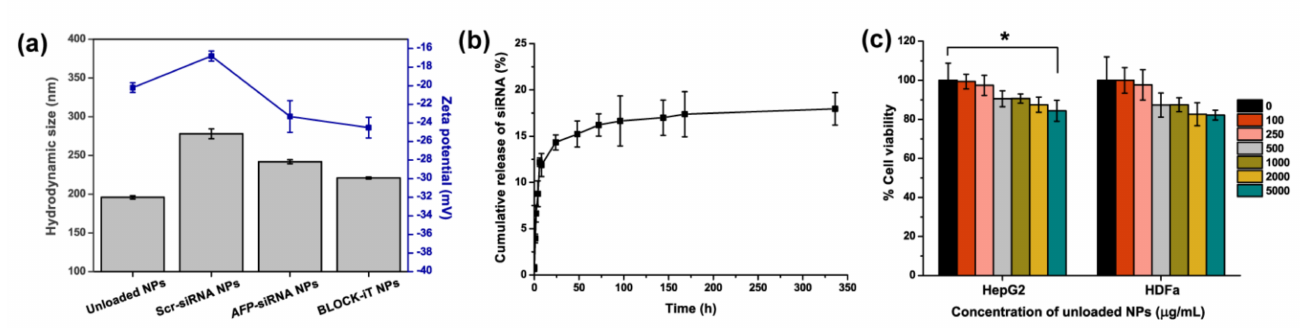
Figure 2. Characteristics of synthesized NPs including unloaded and loaded NPs. ( a ) Hydrodynamic size and zeta potential of unloaded NPs, Scr-siRNA NPs, AFP -siRNA NPs, and BLOCK-iT NPs. ( b ) Releasing profile of loaded siRNA over a 14-day period. BLOCK-iT siRNA was used as a representative of AFP -siRNA. ( c ) Percentage of cell viability of cancer and normal fibroblast cell lines (i.e., HepG2 and HDFa, respectively) after treatment with different concentrations of unloaded NPs for 24 h. Significance was set at p -values of p < 0.05 and indicated with an asterisk